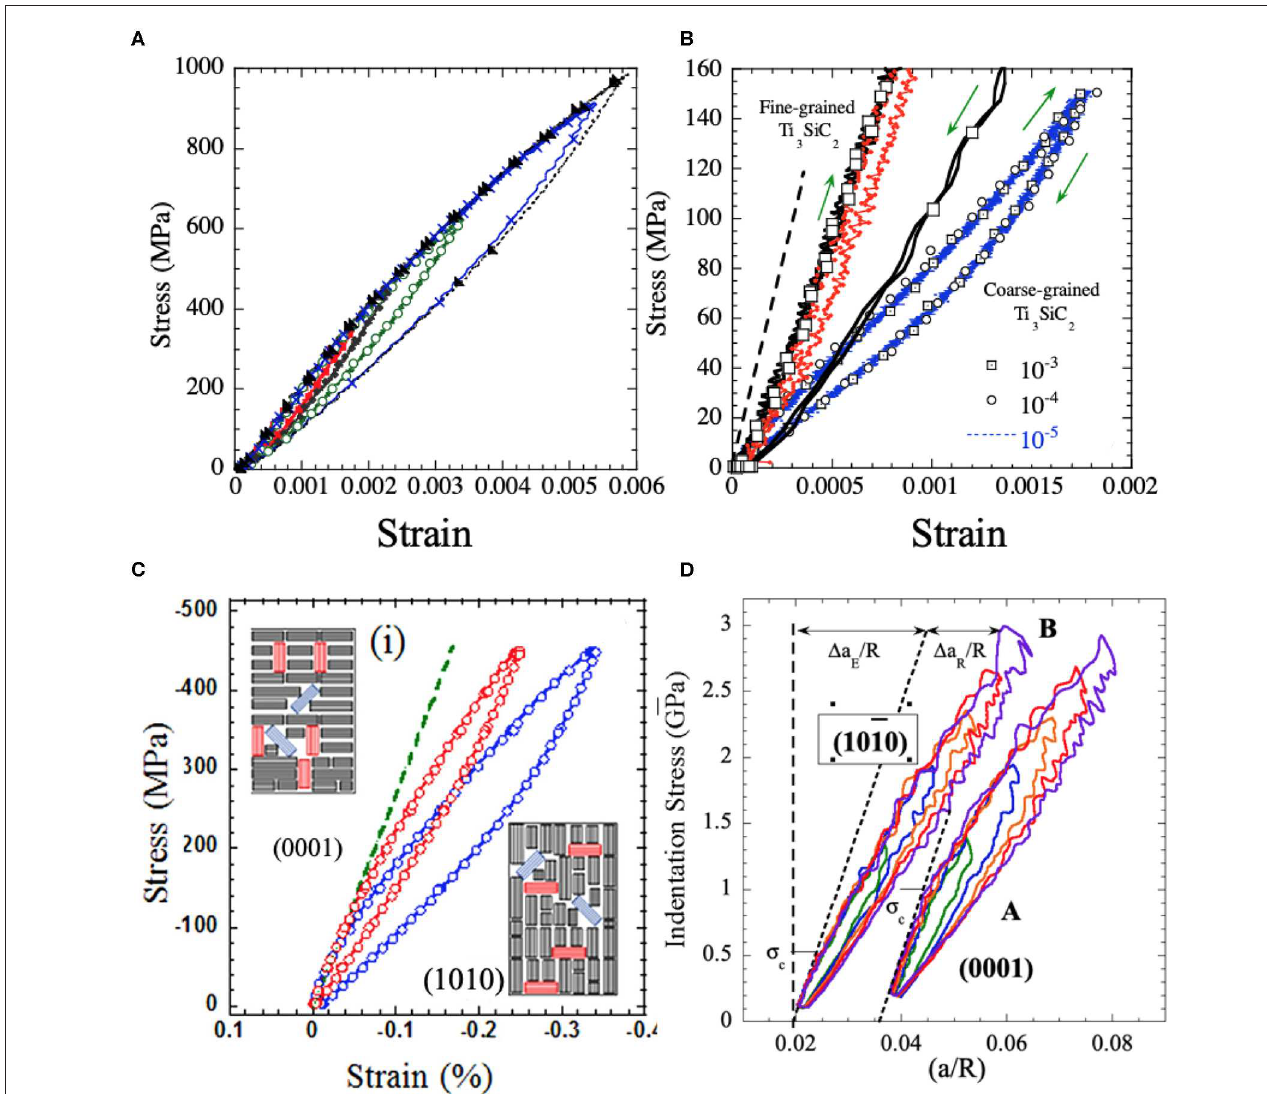
FIGURE 2 | Typical bulk cyclic compressive spontaneously reversible stress/strain loops in (A) , Fine-grained, FG, Ti 3 SiC 2 , (B) Same as (A) but showing dramatic difference in response between coarse-grained, CG (small blue loops), and FG samples (black and red loops). Note the blue loops comprise three different loops, obtained at three strain rates indicated. Red loop—obtained on FG sample at 250 MPa—is significantly stiffer and smaller in area than the CG loops at the same stress; Within the resolution of the measurement, the three loops at the various strain rates are identical. (C) Highly oriented polycrystalline Ti 2 AlC samples where, (i) basal planes are mostly normal to the applied load (red loop) or, (ii) parallel to the applied load (blue loop) (Shamma et al., 2015). In insets, thin lines represent basal planes. Black and red rectangles represent majority and minority hard grains, respectively. Blue rectangles represent soft grains. (D) NI stress vs. a/R, where a is the contact radius and R is the indenter diameter, for basal planes loaded edge on, viz. ( ¯ 1010) and those loaded normal to the basal planes, viz. (0001) (Griggs et al., 2017). (C,D) Reproduced with permission from Acta Materialia, Elsevier.